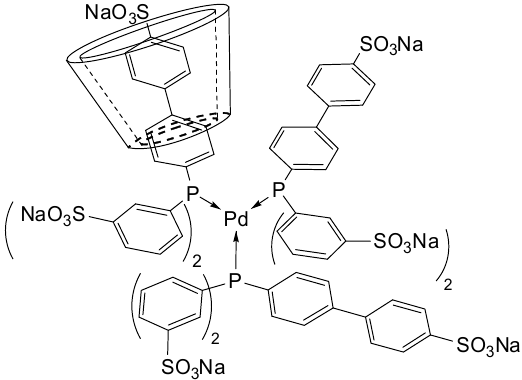
Figure 11. 2D T-ROESY spectrum of a solution containing β -CD (11 mM) and Pd(P(Biph)Ph 2 TS) 3 (11 mM) at 25 °C in D 2 O.